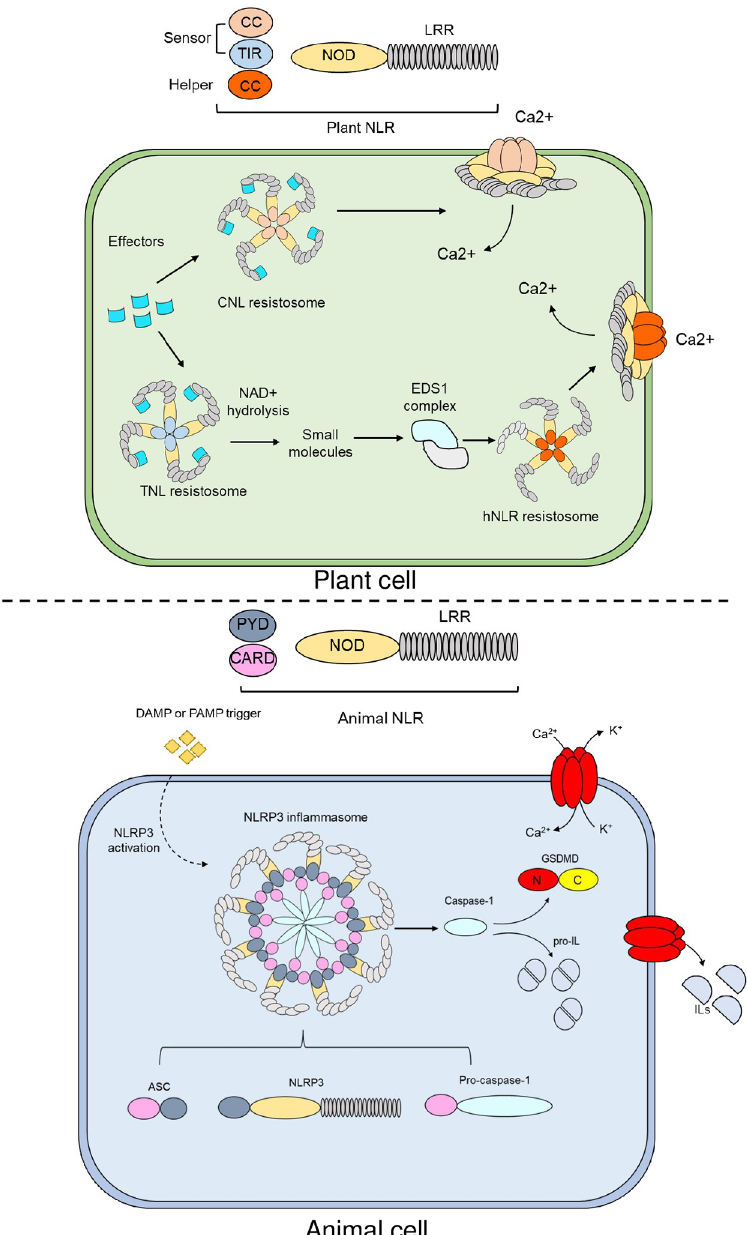
Fig 1. Domain architecture of NLR immune receptors and general activation mechanisms of resistosomes and inflammasomes in plants and animals, respectively. NLRs are modular tripartite immune receptors comprised of an N-terminal signaling domain, a NOD and LRR domain. In plants, NLRs are broadly classified into sNLRs and hNLRs based on their function during the immune response. Sensors are divided into CC- or TIR-NLR, whereas helpers carry a CC domain at their N-terminus. Upon pathogen perception, CNLs oligomerize into a pentameric wheel-like structure, whereas TNLs oligomerize into a tetrameric structure collectively known as resistosomes. While CNLs can sense pathogen effectors and execute cell death by acting as permeable Ca 2+ channels with no need of hNLRs, TIR domains from TNLs act as NAD+ hydrolases generating by-products or small molecules that bind to EDS1 complexes. Allosteric changes in EDS1 complexes allow interaction with hNLRs. Oligomerization of certain hNLRs into a pentameric resistosome with Ca 2+ channel activity at the PM drive ion flux imbalances that resultin HR-cell death [9,10].CNL, coiled-coil-NLR; hNLR, helper NLR; HR, hypersensitive response; LRR, leucine-rich repeat; NLR, nucleotide-binding leucine-rich repeat; NOD, nucleotide oligomerization domain; PM, plasma membrane; sNLR, sensor NL; TNL, Toll Interleukin 1 receptor-NLR.